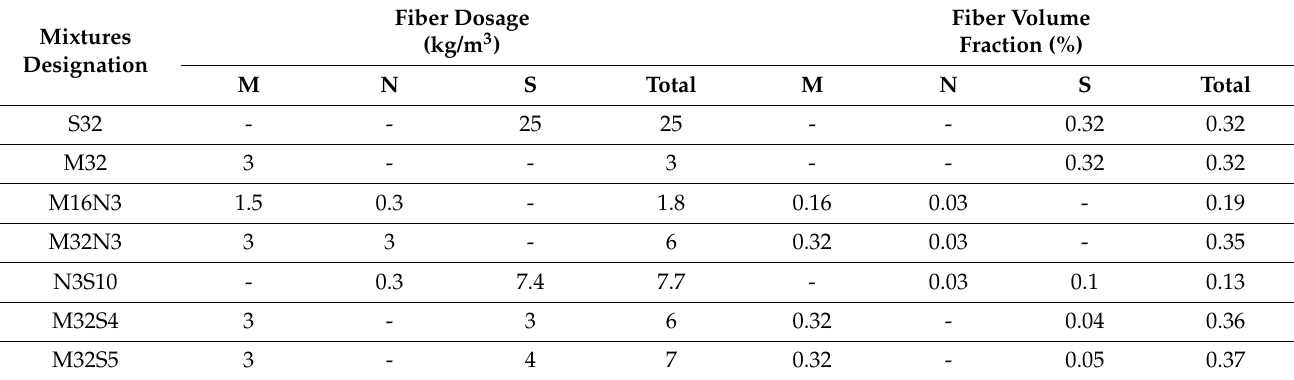
Table 3. Fiber proportions for each